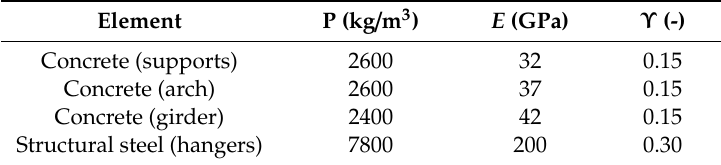
Table 1. Material parameters applied in the numerical model of the viaduct.